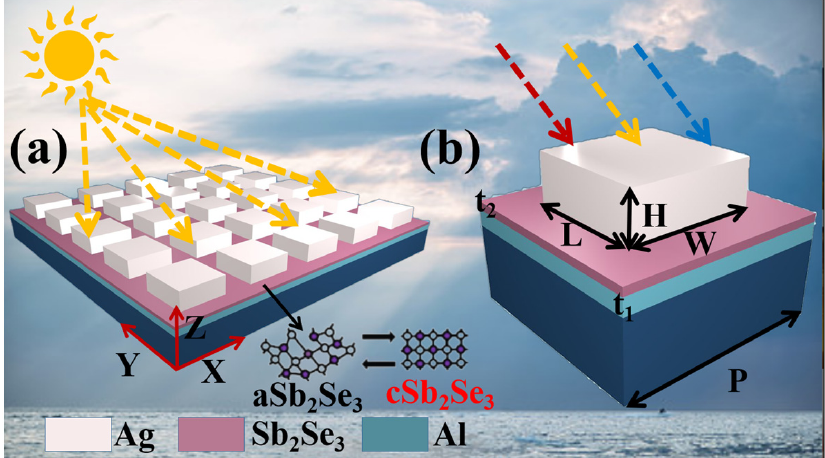
Figure 1. ( a ) Schematic diagram of the Sb 2 Se 3 -based metamaterial absorber; ( b ) unit periodic structure parameters.